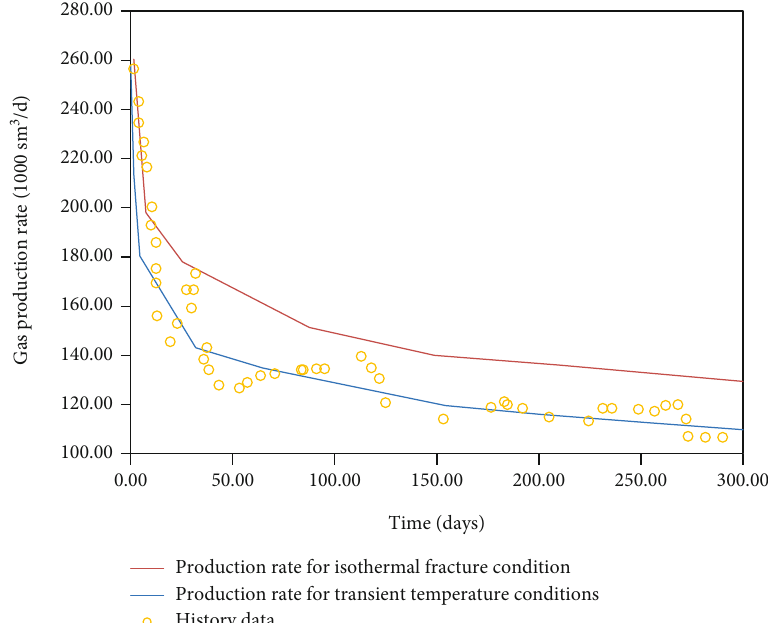
Figure 6: Comparison of production predictions between the isothermal fracture model and the transient heat fracture propagation model. Dots represent history